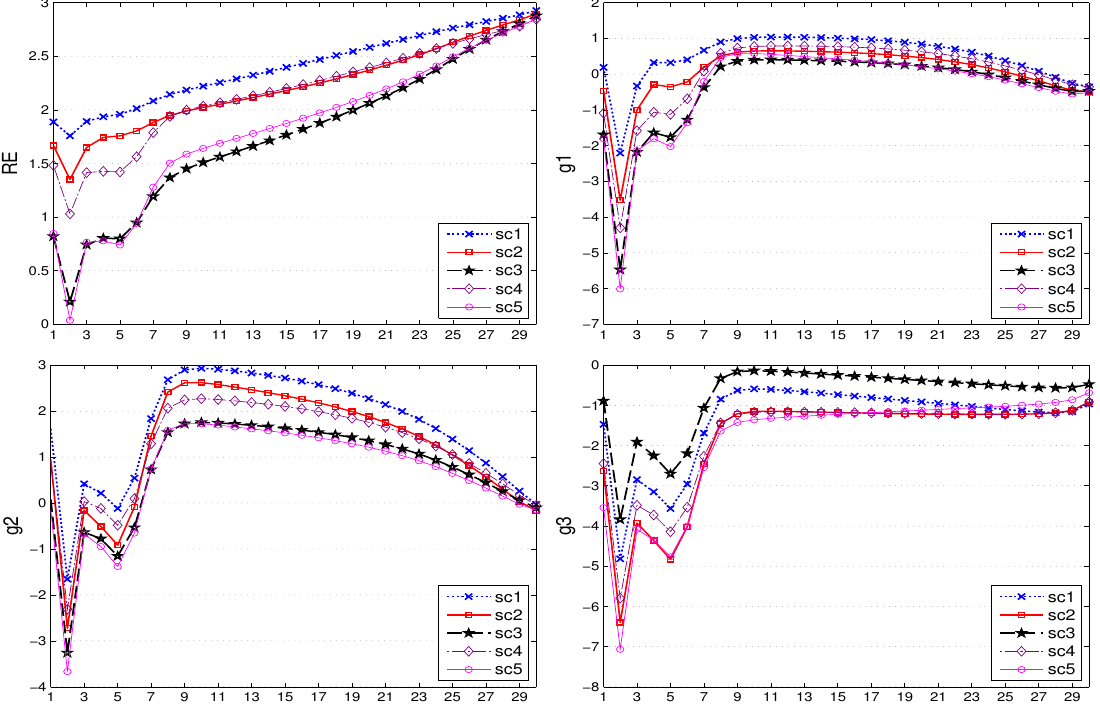
Figure 1. Control variables (prime rate ( R Et ) and fiscal surplus ( g it